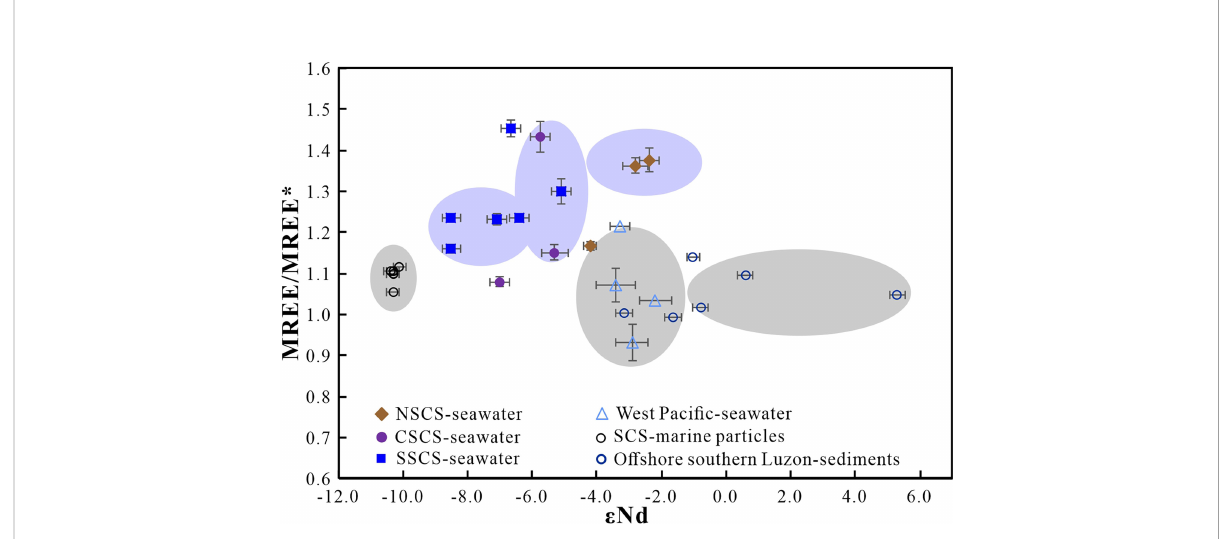
FIGURE 6 Plot of MREE/MREE* vs. ϵ Nd values for West Paci fi c seawater, SCS seawater, offshore southern Luzon sediments, and the SCS sinking particles (Amakawa et al., 2000; Wei et al., 2012; Wu et al., 2015; Behrens et al., 2018b; Liu et al., 2018). MREE/MREE* = 2 × (Gd + Tb + Dy)/(La + Pr + Nd + Tm + Yb + Lu) (All REEs are PAAS-normalized; Martin et al.,